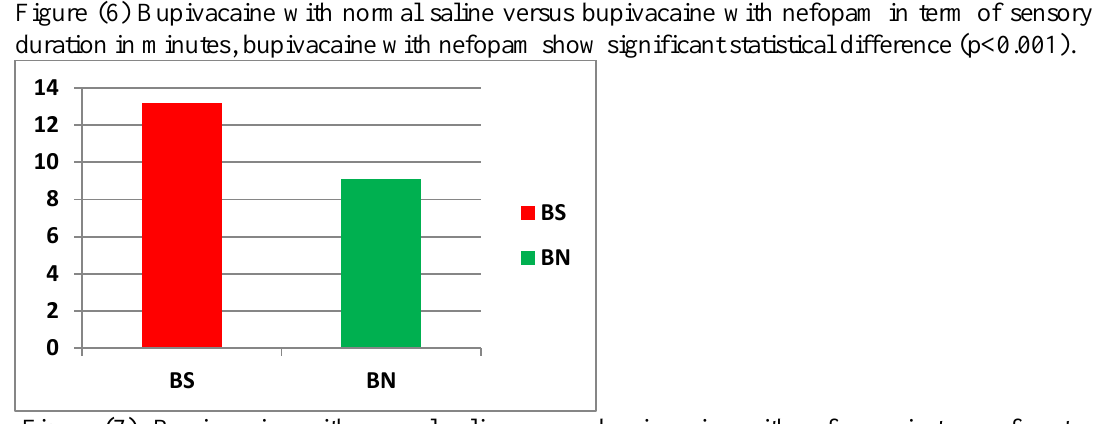
Figure (7) Bupivacaine with normal saline versus bupivacaine with nefopam in term of motor block onset in minutes, bupivacaine with nefopam show significant statistical difference